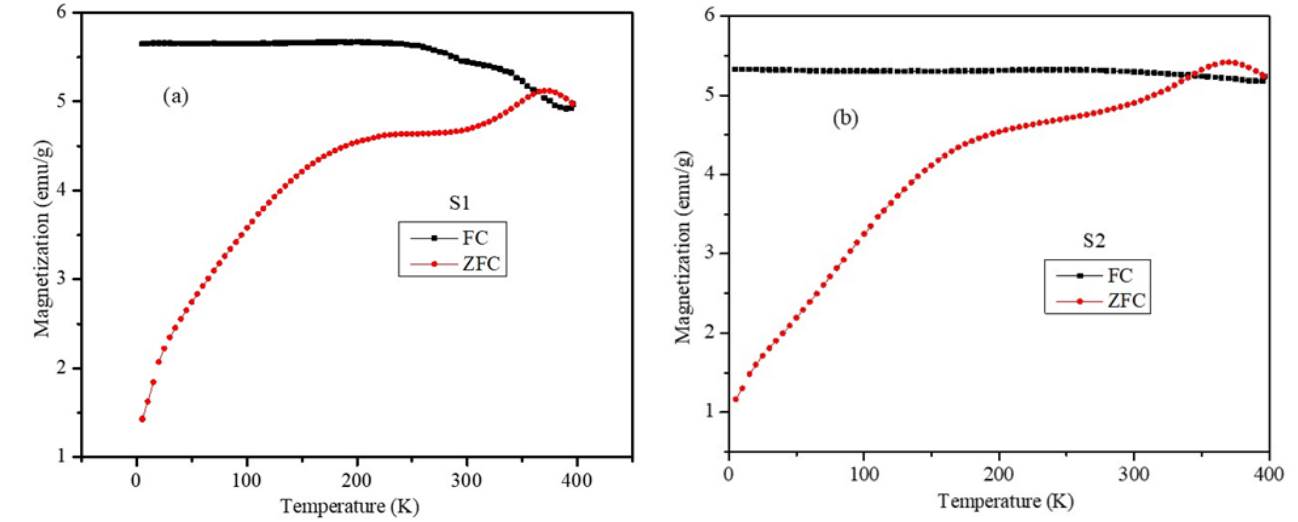
Figure 7. The M-T plots under the ZFC and FC conditions for the ( a ) S1 and ( b ) S2 samples. The exchange bias values of the core-shell nanoparticles were obtained from the hysteresis loops of Figure S1a–h in the supplementary data. To calculate the exchange bias values and coercivity of the nanoparticles, the shift in the MH loops at the origin under different field-cooling values was used. The zoomed portion of the MH plots is shown in Figure 8a,b, from which the shift in the magnetization and field values were obtained.